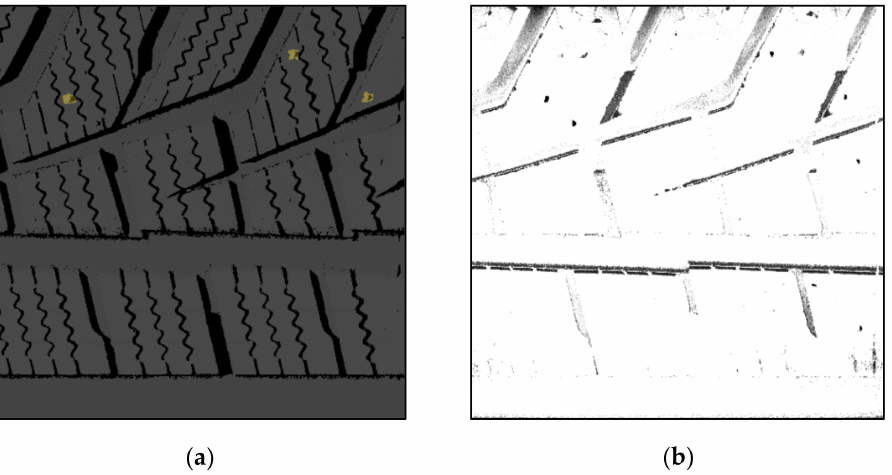
Figure 8. Comparison of the original image and weighted image: ( a ) original image labeled with vent spew error; ( b ) weighted image based on the original image.